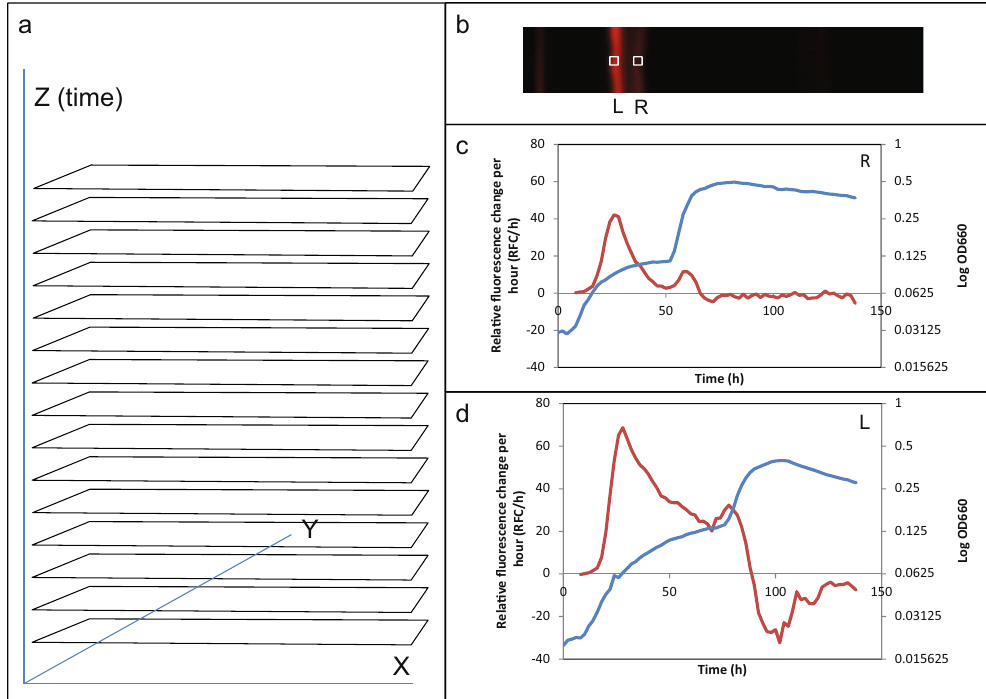
Figure 2. Constructing a stack of images with a time dimension and using this for analysis. ( a ) Images of the area of interest (as in Fig. 1c) are stacked along a time axis Z. ( b ) Two regions of interest were defined, one at the right side (R) of the bacterial reporter strain streak that met the growing fungus first and one at the left (L). ( c ) Plot of log OD (blue and right scale) showing an initial exponential growth of the bacterium and the arrival of the fungal colony front, made up of tip growing fungal cell filaments (hyphae), at approximately 50 h. The red curve (left scale) shows fluorescence change (mCherry protein synthesis rate) per hour of the reporter gene product, indicating changes in expression rate of all genes regulated by the nunF promoter. The mCherry synthesis rate has a peak in the deceleration phase of the growth and a second peak is seen at the arrival of the hyphal front. ( d ) Same as in ( c ) but since the arrival of the hyphal front is later the second peak is later and also here it coincides with the arrival of the hyphal front, at approximately 80